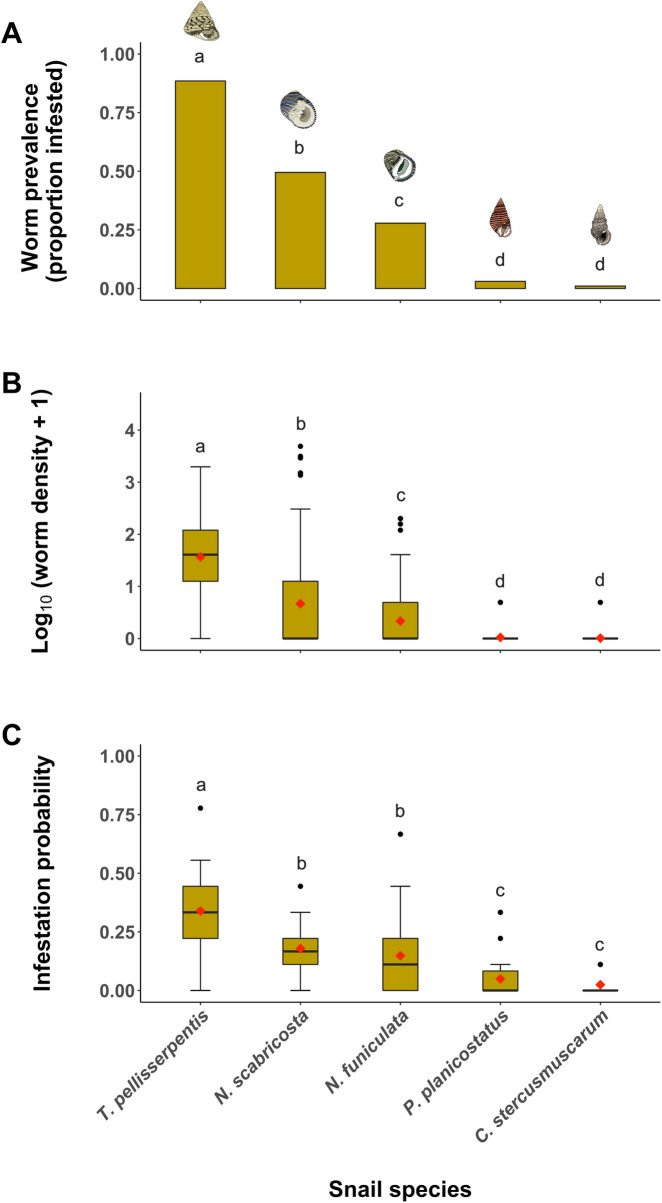
Prevalence and density of flatworm infestation in the field and flatworms’ host choice in the laboratory.(A) Proportion of snail individuals infested by flatworms in the field, (B) box plot of flatworm infestation density (no. worm per snail) in the field, and (C) box plot of infestation probability (i.e., a proportion of individual worms selecting a particular host species) measured during the host selection experiment. In box plots, mean values for different snail groups are represented by red diamond symbols. Different letters indicate a significant difference based on post hoc multiple comparisons (Holms-corrected P < 0.05).